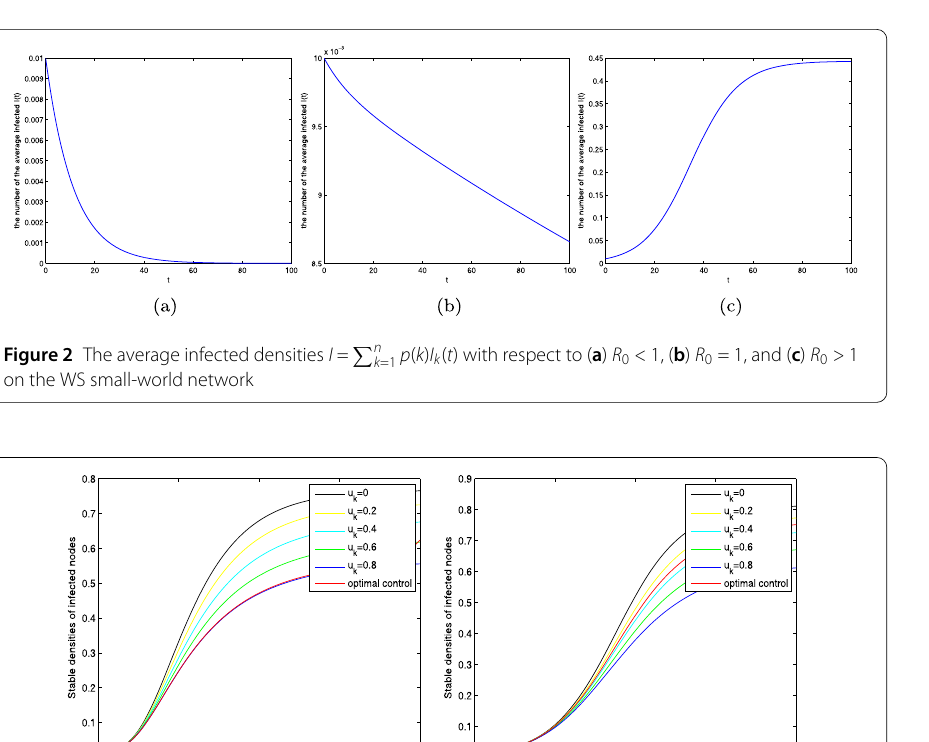
(cid:5) n k =1 p ( k ) I k ( t ) with respect to five kinds of constant control ( t ) k